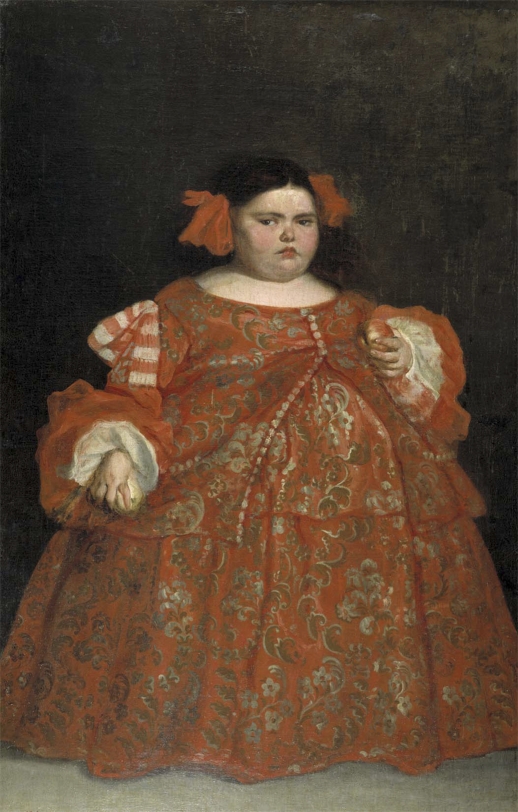
Portrait of Eugenia Martinez Vallejo at Museo del Prado (Madrid)Eugenia Martinez Vallejo was portrayed by Spanish painter Juan Carreño Miranda in 1680. It has been suggested that she had PWS [19]. At the time of the painting, she was 6 years old and in the hyperphagic (over eating) phase of the disease, which occurs after weaning. She weighed 120 pounds (∼54 kg) and was portrayed with two pieces of food in her hands, which correspond to these patients' voracious appetite. Other symptoms pointing toward this disease include her short stature, almond-shaped eyes, small triangular mouth, and small hands.